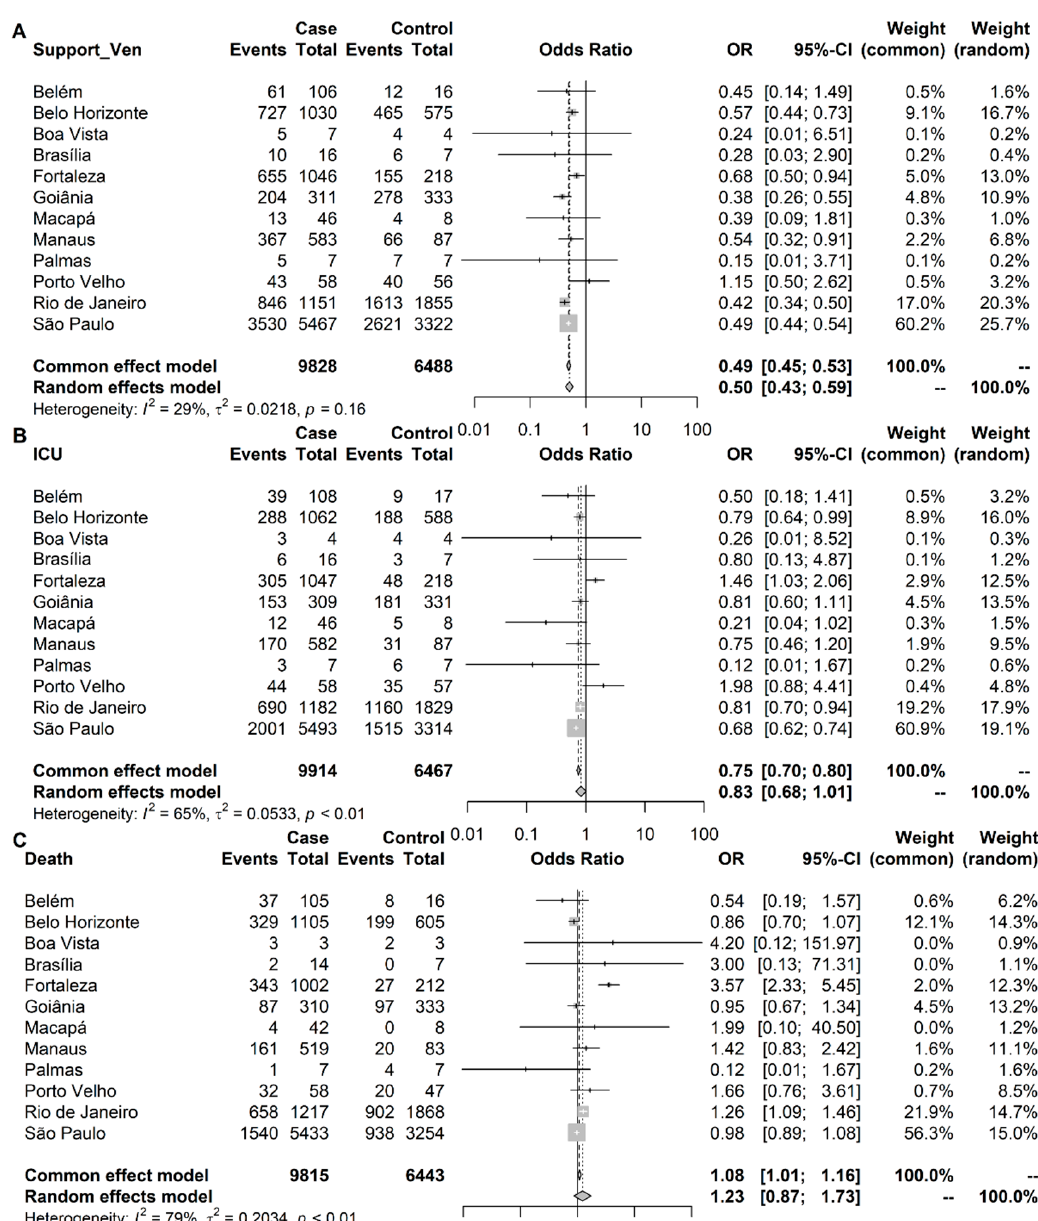
Figure 5. Forest plot of effect sizes measured between Omicron (case) and Delta (control) groups in COVID-19 patients for: ( A ) need for ventilatory support: 9828 cases and 6488 controls; ( B ) intensive care unit admission: 9914 cases and 6467 controls; and ( C ) death: 9815 cases and 6443 controls, in a meta-analysis of 12 different Brazilian capitals according to the periods in which Omicron (case) and Delta (control) VOCs had a minimum prevalence of 90% in each capital city.